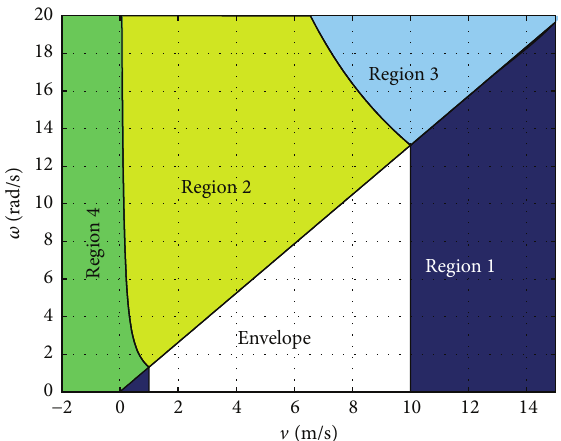
Figure 7: Region classification for second stage saturation.